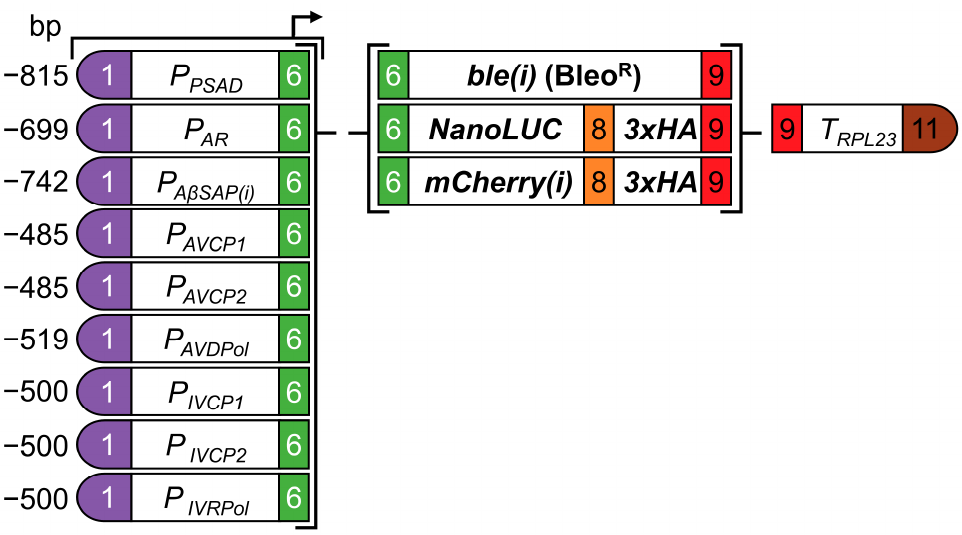
Figure 1. Schematic representation of reporter modules to test viral promoter activity in Chlamydomonas. The domesticated viral promoter sequences of capsomer (CP) and DNA/RNA-polymerase genes (D/RPol) were synthesized according to the MoClo syntax, generating fusion sites suitable for cloning into positions A1-B2. The color code for the 11 fusion sites was introduced previously [30]. The established promoters PSAD , AR and A β SAP(i) were used as benchmarks. Every promoter was assembled with ble(i) , NanoLUC , and mCherry(i) reporters and the RPL23 terminator. NanoLUC and mCherry(i) reporters also contain sequences coding for a 3xHA-tag. (i) indicates the presence of the first RBCS2 intron.